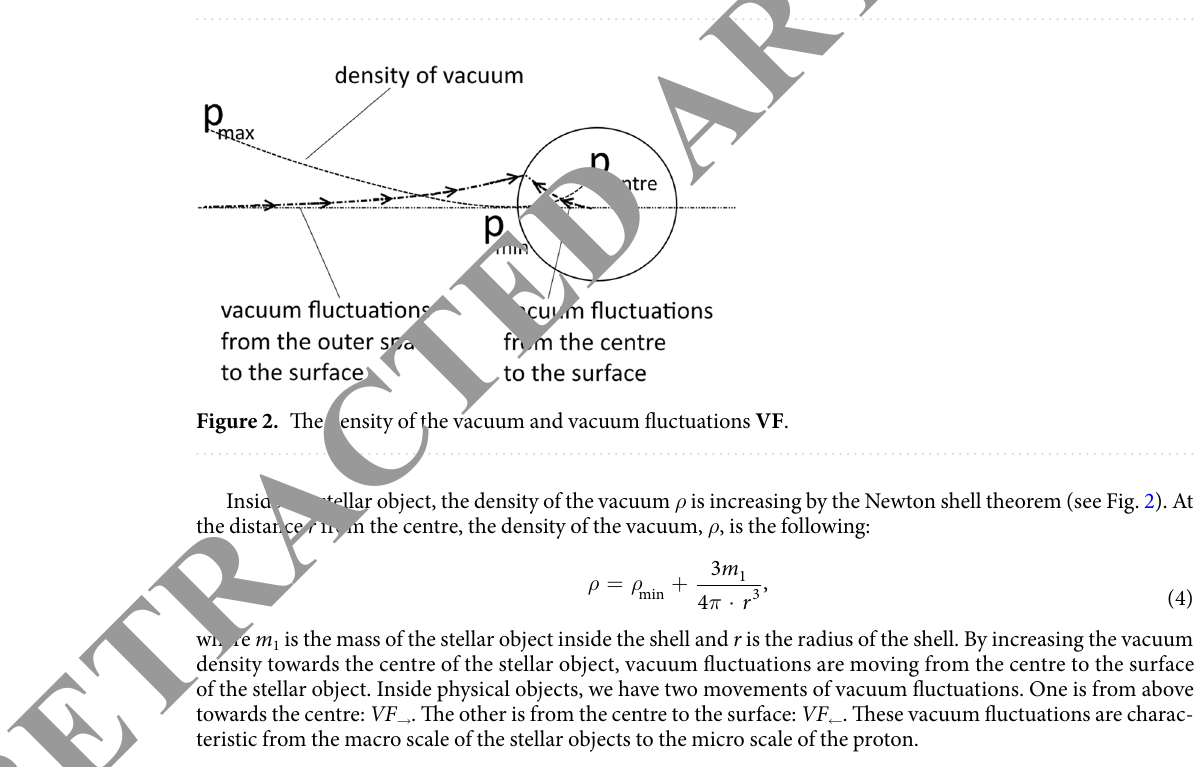
Figure 1. Vacuum fluctuations as the origin of inertial mass and of gravitational mass.